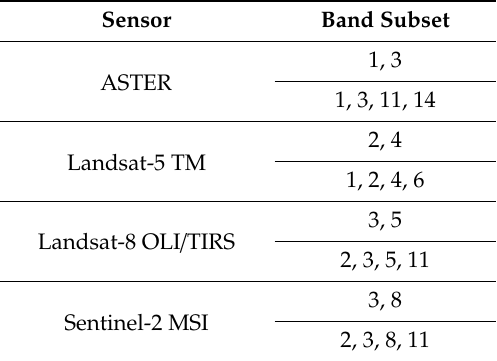
Table A3. Band subsets for selective PCA in Li pegmatite